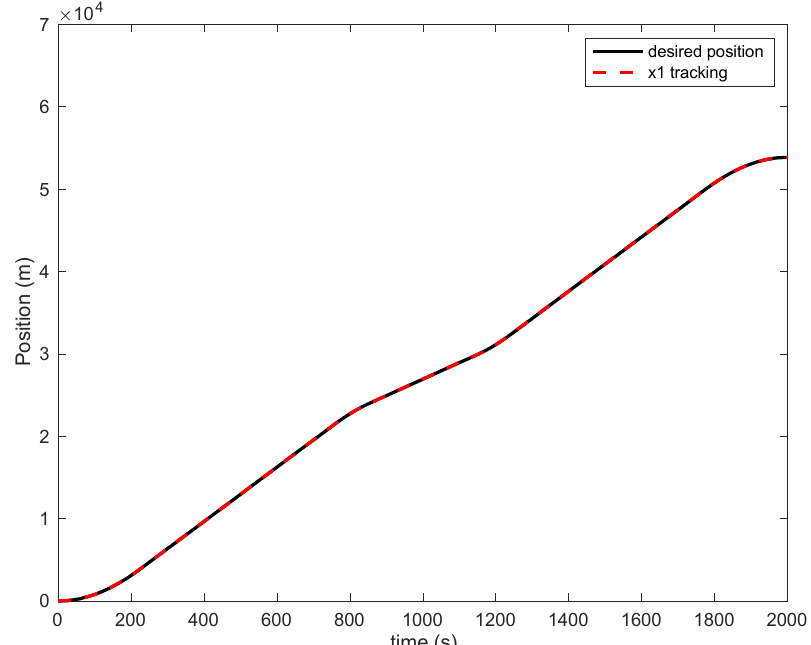
Figure 4. Position tracking performance.